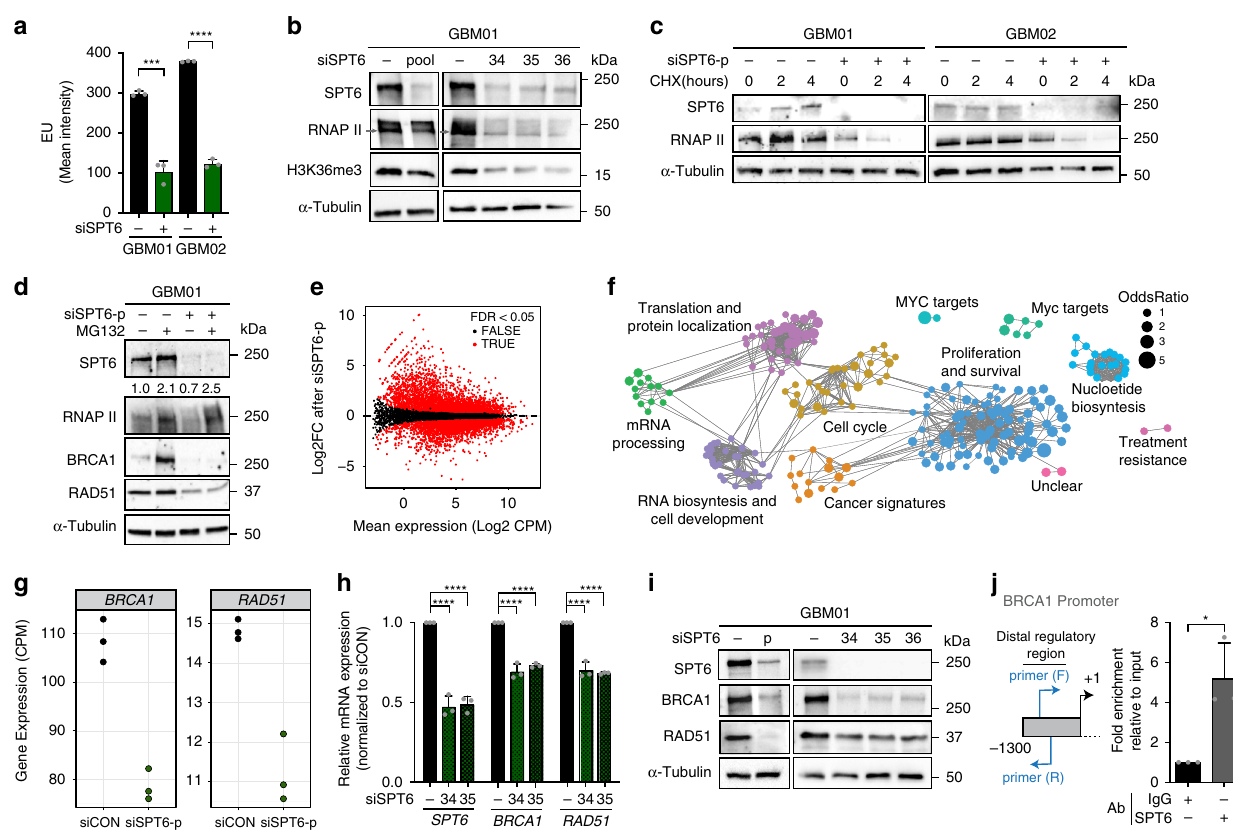
Fig. 4 SPT6 as a transcriptional regulator of HR gene expression. a FACS analysis of global transcription in GSCs transfected with siCON or siSPT6-p. Data shown as mean ± s.d. *** p = 0.0003, **** p < 0.001; two-tailed unpaired t -test. b Representative immunoblot analysis of SPT6, RNAP II and H3K36me3 levels in GSCs transfected with siCON, siSPT6-p or siSPT6-34, siSPT6-35 or siSPT6-36. c Representative immunoblot analysis of SPT6 and RNAP II levels in GSCs transfected with siCON or siSPT6-p and exposed to cycloheximide (CHX; 20 µ g ml − 1 ) at 0, 2 or 4 h. d Representative immunoblot analysis of SPT6, RNAP II, BRCA1 and RAD51 levels in GSCs transfected with siCON or siSPT6-p followed by MG132 treatment for 5 h (20 µ M). e MA plot depicting the extend of transcriptional changes associated with SPT6 loss. Red dots indicate signi fi cantly differentially expressed genes. EdgeR function, FDR < 0.05. f Gene Set Enrichment Analysis (GSEA) showing signi fi cantly downregulated signaling pathways in GSCs with silenced SPT6 (siSPT6-p). The circle size speci fi es the enrichment (odds ratio) and the thickness of the connecting lines the overlap in-between gene sets. g BRCA1 and RAD51 are downregulated in GSCs with silenced SPT6. p = 2.6e-07 ( BRCA1 ) and p = 1.8e − 0.3 ( RAD51 ) edgeR function. h qRT-PCR analysis of SPT6, BRCA1 and RAD51 expression in GSCs with silenced SPT6 (siSPT6-34 and siSPT6-35). House-keeping gene control: HPRT. Data are normalized to siCON and presented as mean ± s.d. **** p < 0.001; two-way ANOVA followed by Dunnett ’ s multiple comparison test. i Representative immunoblot analysis of SPT6, BRCA1 and RAD51 expression in GSCs transfected with siCON or siSPT6-p. j Left: Schematic representation of BRCA1 promoter primer sites. Right: Chromatin immunoprecipitation of SPT6 followed by qRT-PCR in GSCs. Bar graph shows relative fold enrichment compared to input (10%). Data are presented as mean ± s.d. * p = 0.0148; two-tailed unpaired t -test. N = 3 biological independent experiment in ( a – d ), ( h – j ). Loading control: α -Tubulin in ( b – d ), ( i ). Source data are provided as a Source data fi